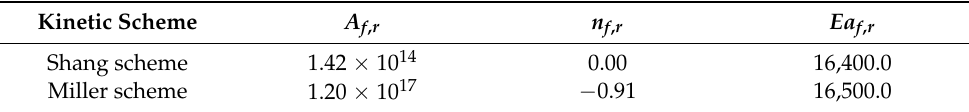
Table 5. Comparison of reaction rate coefficients of H + O 2 = O + OH.